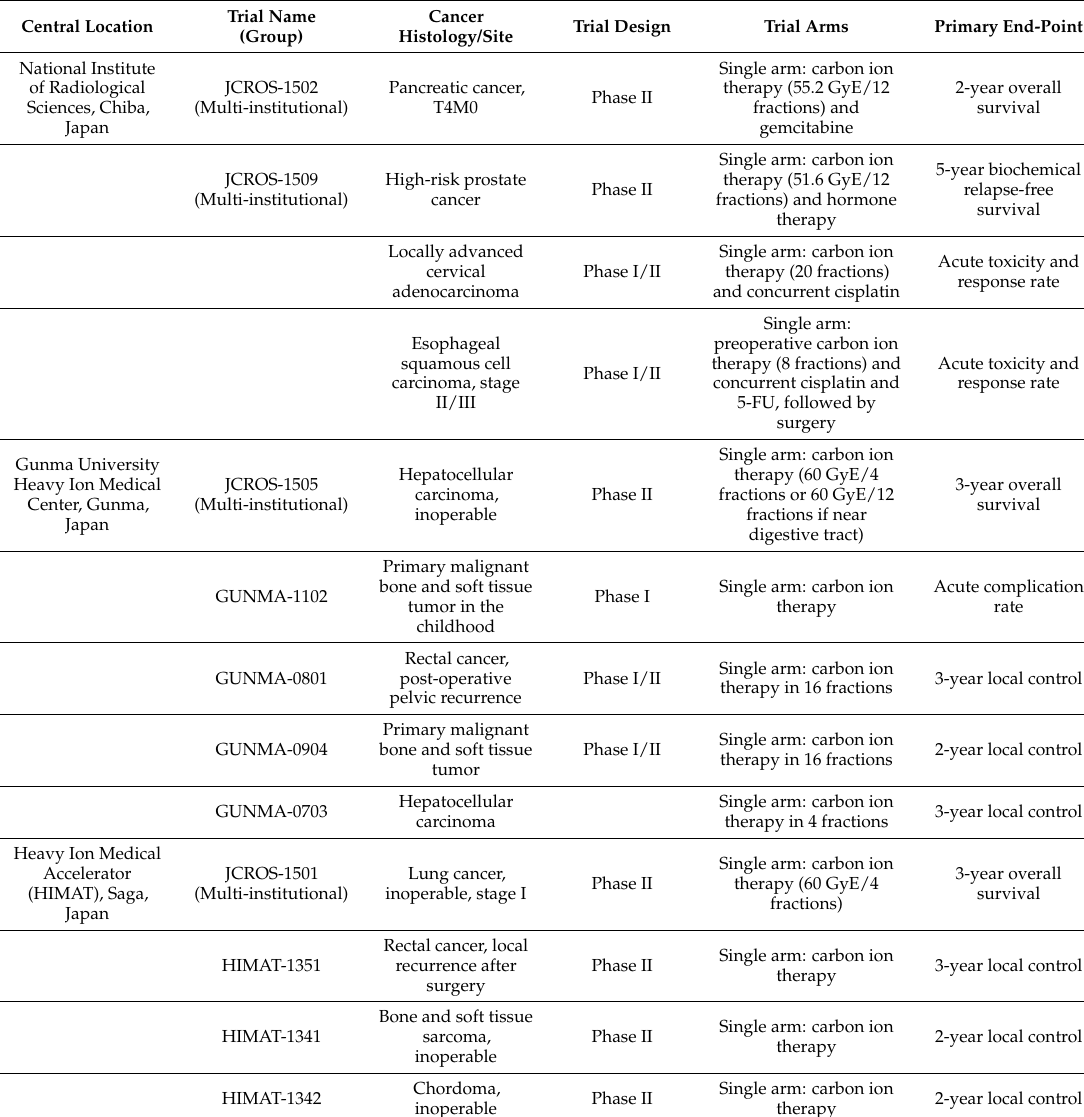
Table 1. A list of selected open and/or recruiting clinical trials using carbon ion radiotherapy (CIRT) alone or in combination with other treatment modalities. This list has been compiled using information shared by Dr. Shigeru Yamada (National Institute of Radiological Sciences, NIRS) and Dr. Morihito Takita (Ion Beam Radiation Oncology Center in Kanagawa, iROCK), and from information available online on www.clinicaltrials.gov and www.umin.ac.jp/ctr. IMRT: intensity-modulated radiotherapy; JCROS: Japan Carbon-Ion Radiation Oncology Study Group; PSA: prostate-specific antigen; GM-CSF: granulocyte macrophage colony-stimulating